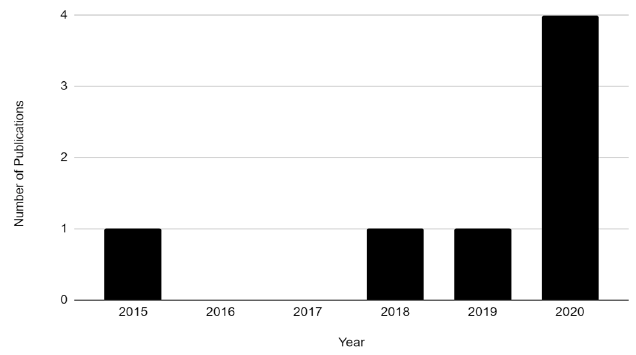
Figure 2. Number of publications throughout the years.